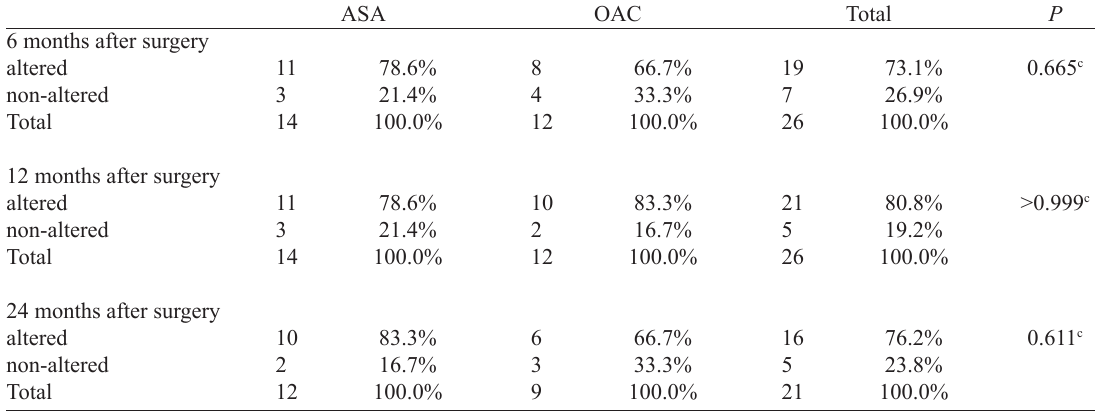
Table 4. Distribution of the results of tomography in children of ASA and ACO